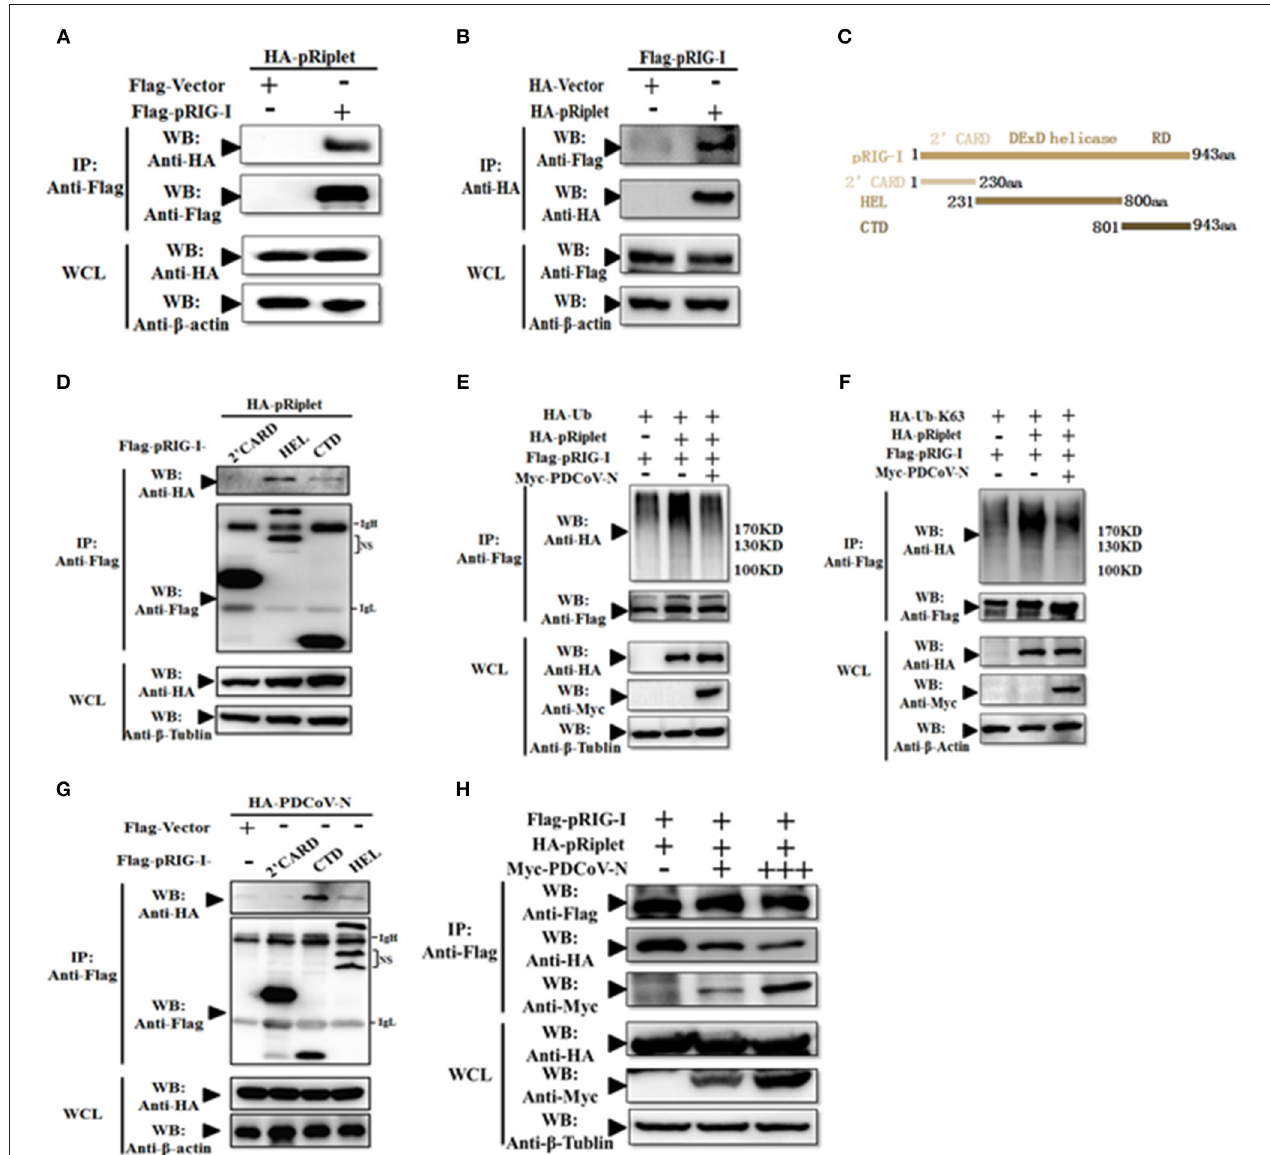
FIGURE 7 | PDCoV N protein inhibited pRiplet-induced pRIG-I K63-polyubiquitination. (A,B) HEK293T cells were co-transfected with HA-tagged pRiplet or Flag-tagged pRIG-I or empty plasmid as the control with Flag-tagged pRIG-I or HA-tagged PDCoV-N expression plasmid, respectively. After 28h of transfection, the cells were lysed for Co-IP by Flag-affinity gel or HA-affinity gel. (C) Schematic representation of porcine RIG-I fragments used for Co-IP analyses. (D,G) HEK293T cells were co-transfected with HA-tagged pRiplet (D) or HA-tagged PDCoV-N (G) with three porcine RIG-I fragments (Flag-pRIG-I-2 ′ CARD, Flag-pRIG-I-HEL, Flag-pRIG-I-CTD), or expression plasmid, respectively. After 28h of transfection, the cells were lysed for Co-IP by Flag-affinity gel. (E,F) HEK293T cells were co-transfected with Flag-tagged pRIG-I and HA-Ub or HA-Ub-K63 with Myc-tagged PDCoV-N or HA-tagged pRiplet or empty control plasmid, respectively. After 28h of transfection, the cells were lysed for Co-IP by Flag-affinity gel. (H) HEK293T cells were co-transfected with HA-tagged pRiplet and Flag-tagged pRIG-I with Myc-tagged PDCoV-N or empty plasmid as the control expression plasmid, respectively. After 28h of transfection, the cells were lysed for Co-IP by Flag-affinity gel. Western blot was used to detect the immunoprecipitants and WCLs